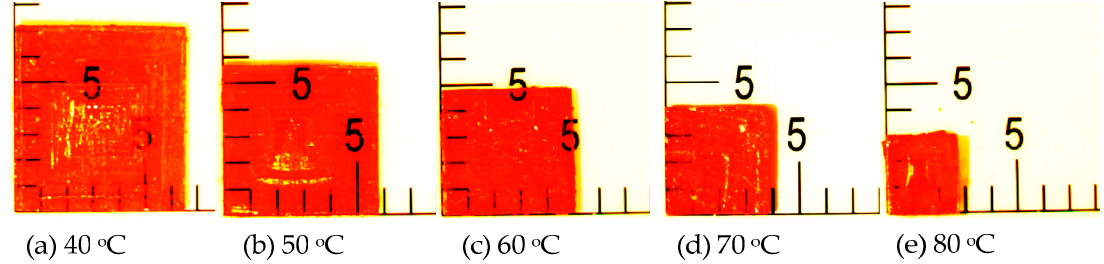
Figure 2. Pictures of MAPbBr 3 crystals prepared at various temperature. The unit of scale is 1 mm.